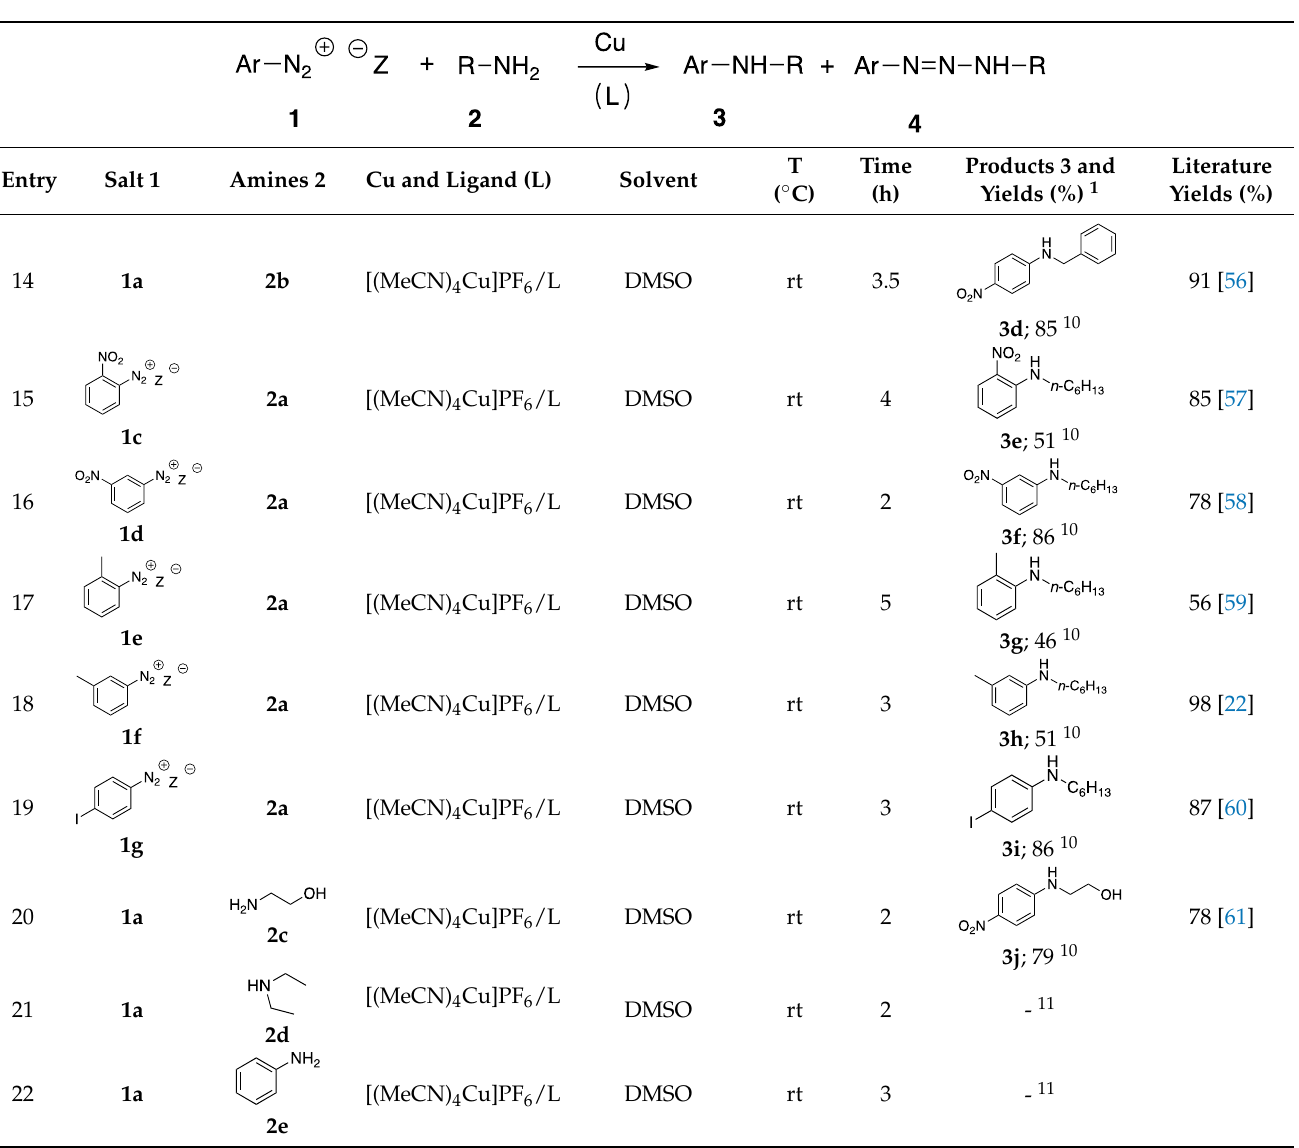
Table 1. Cont. Table 1. Ullmann-type coupling between arenediazonium o -benzenedisulfonimides 1 and amines